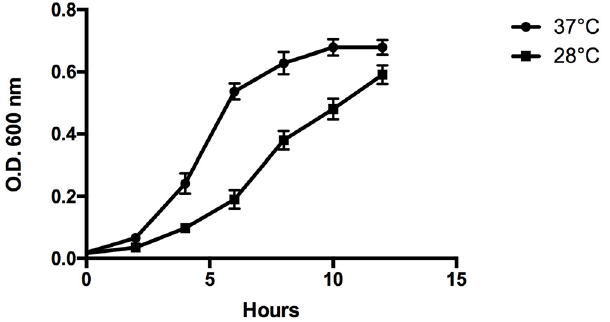
Fig 1. S . suis g rowth curves at 28°C and at 37°C. 1 ml of culture was sampled and absorbance (or optical density) at 600 nm (OD 600 ) was measured every 2 hours; the difference between the two growth curves was weakly significant ( p =